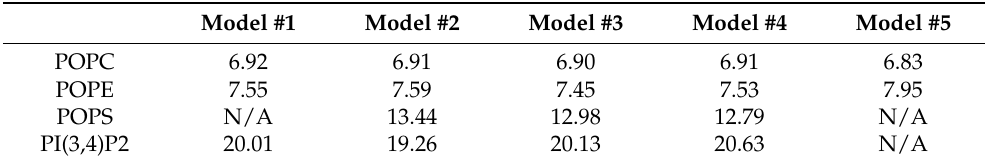
Table 4. Average number of water molecules in contact with the lipids via hydrogen bonding. Not applicable (N/A).